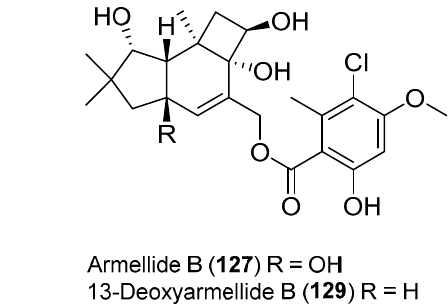
Figure 19. Structures of armellides 126 – 129 isolated from the Armillaria genus of fungi.